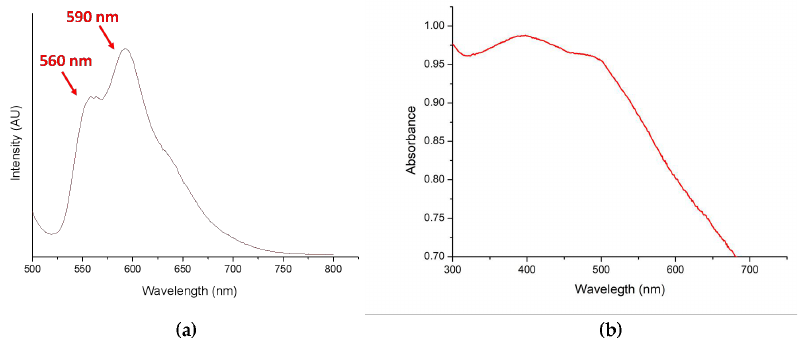
Figure 5. ( a ) Fluorescence emission spectrum of DOX-loaded particle (DOX-PNIPAM-PMAA@Fe 3 O 4 )